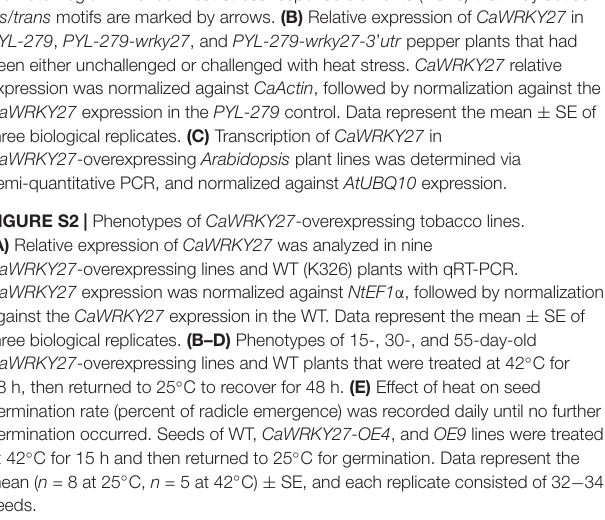
FIGURE S4 | CaWRKY27 expression was repressed in isolated pepper leaves under heat stress with ROS scavenging reagent. (A) Accumulation of H 2 O 2 were detected via DAB staining at 3 h after heat stress (33 ◦ C) and 30 min after recovery (25 ◦ C) with or without 10 mm AsA (ascorbic acid), 100 µ M DPI (diphenyleneiodonium chloride) and 100 µ M quinacrine in isolated pepper leaves. (B) CaWRKY27 expression was determined via qRT-PCR at 3 h after heat stress (33 ◦ C) and 30 min after recovery (25 ◦ C) with or without 10 mm AsA (ascorbic acid) in isolated pepper leaves. Data represent the mean ± SE of three biological replicates. TABLE S1 | Sequences of primers used in this